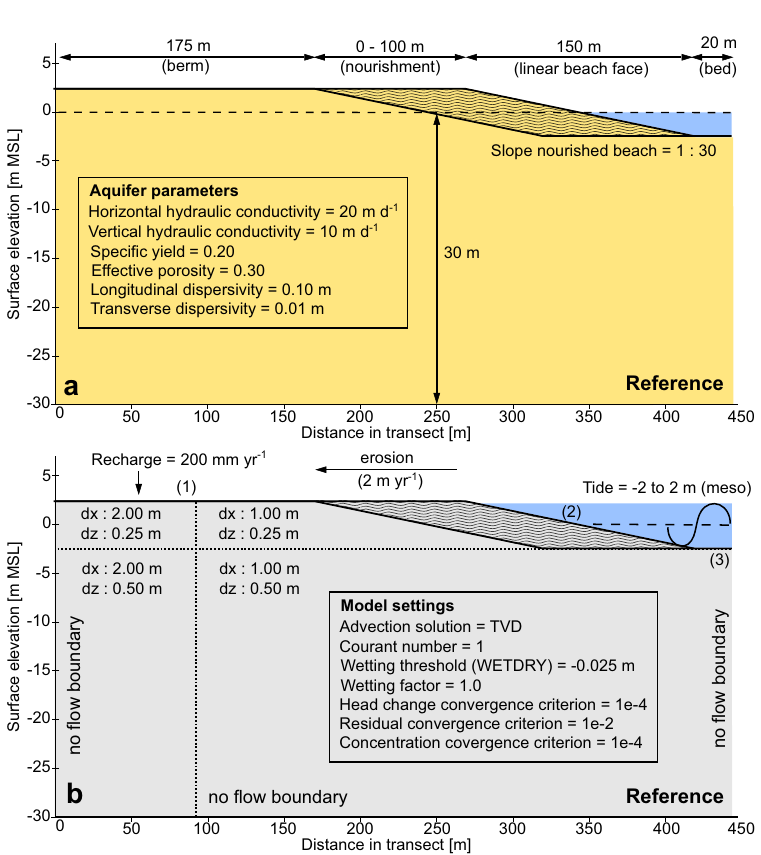
Figure 15. Details of the reference model: model domain, boundary conditions ( b ), aquifer parameters ( a ), model settings ( b ), recharge rate ( b ), slope nourished beach ( a ), tidal range ( b ), and erosion rate ( b ). All of the top six listed processes or properties are equal to the ‘average’ column in Table 3. The beach nourishment is indicated with the wave